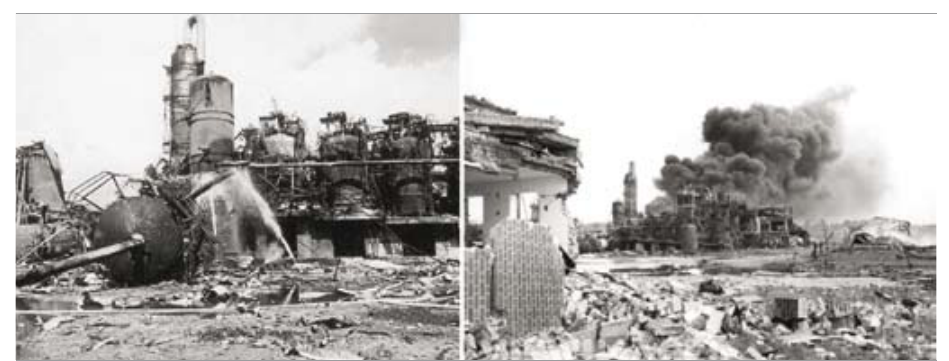
fig. 4. The remains of the Nypro chemical plant at Flixborough after the massive vapour cloud explosion, June 1974 (CCPS